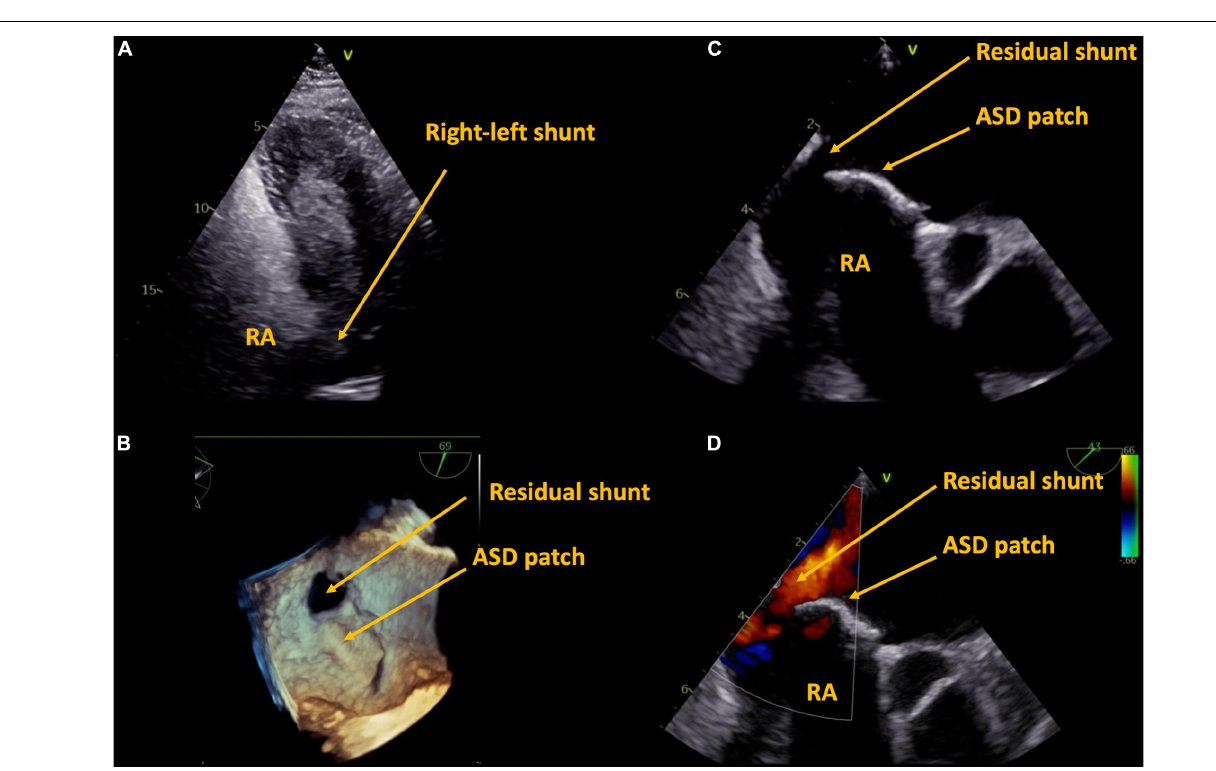
FIGURE 2 | Case 1, 59 year-old patient with a history of surgical ASD closure with partial detachment of the patch. Residual shunt shown by right-heart contrast agent (A) , and by transesophageal echocardiography in 3D (B) , 2D (C) , and 2D color (D) . ASD, atrial septum defect, RA, right